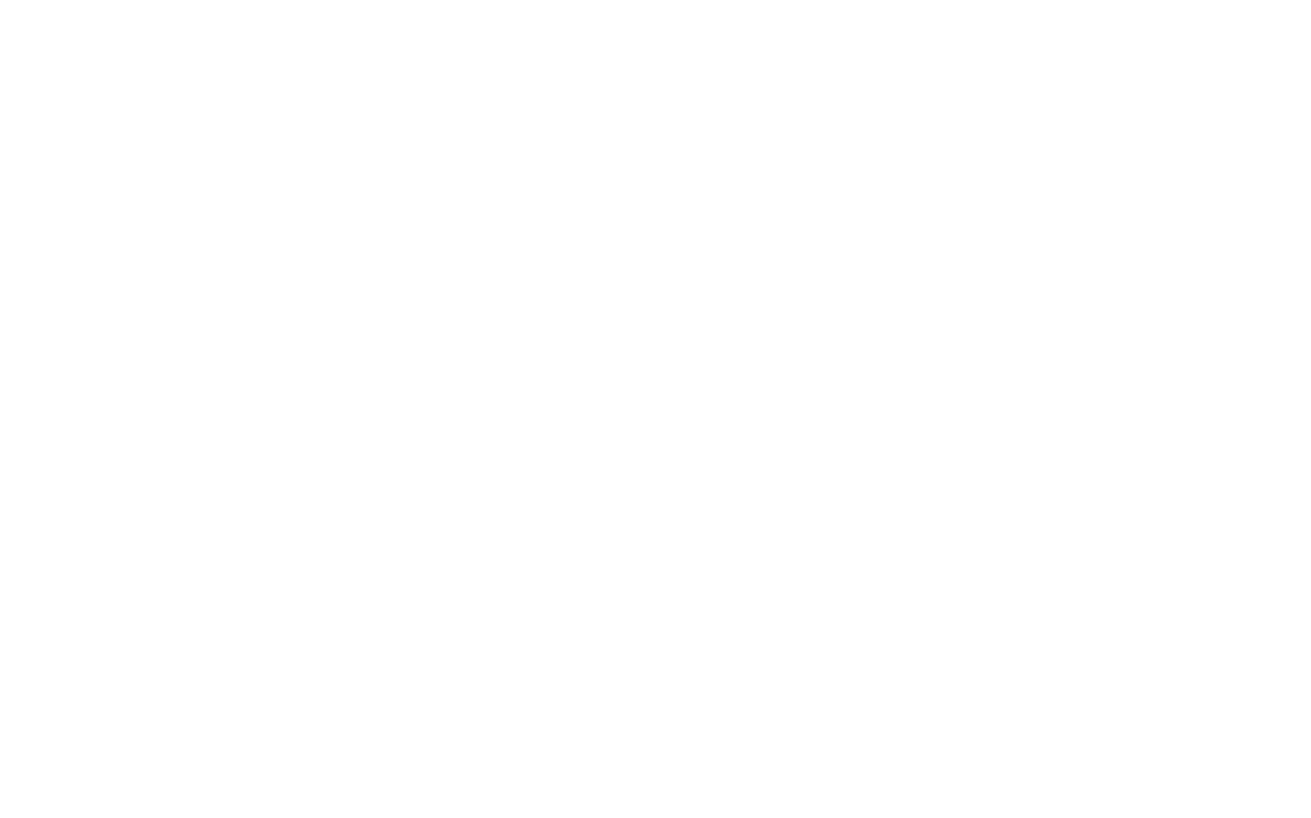
FIGURE B4 | GUIs for the utilities “Bedpostx” and “Tracking & Network” in PANDA. (A) The utility for Bedpostx. (B) The utility for tractography and network